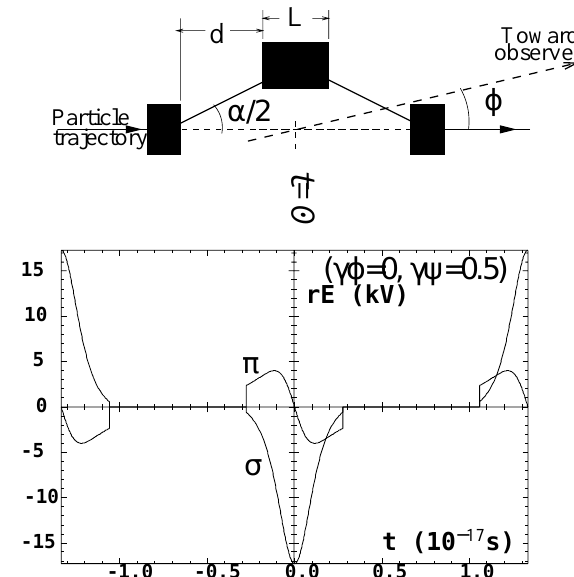
FIG. 6. Top: a three-dipole wiggler. Bottom: typical shape of the electric field impulse in the gw (cid:2) 0 observation direction. Note that the central impulse can be obtained from Eq. (7) with f (cid:2) 0 and the side impulses with f (cid:2) 6a (cid:4) 2